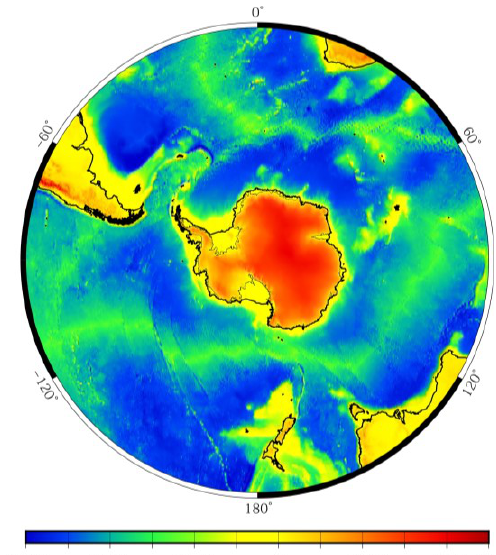
Figure 1. Bathygram of oceans southward of 30 °S , the black lines are the coastlines, the grey lines in Antarctic are the grounding lines (from Antarctic Digital Database http://www.add.scar.org/home/add7) Table 2. RMS of differences between ocean tide models and their RSS /cm